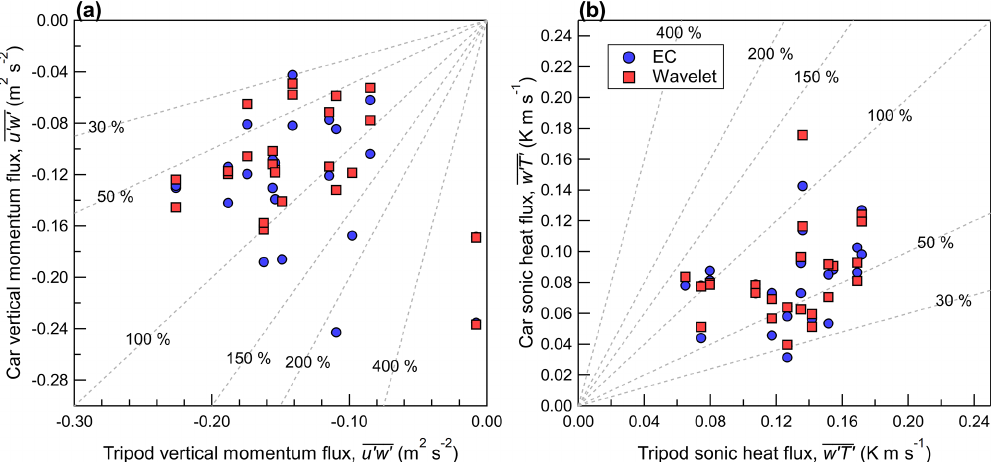
Figure 8. The vertical momentum flux, u (cid:48) w (cid:48) (a) , and the sonic heat flux, w (cid:48) T (cid:48) (b) , measured by the tripod (horizontal) and compared to the mobile car (vertical). Covariances calculated using wavelet analysis and EC are shown as red and blue markers, respectively. Dashed gray lines denote constant percentages of the independent